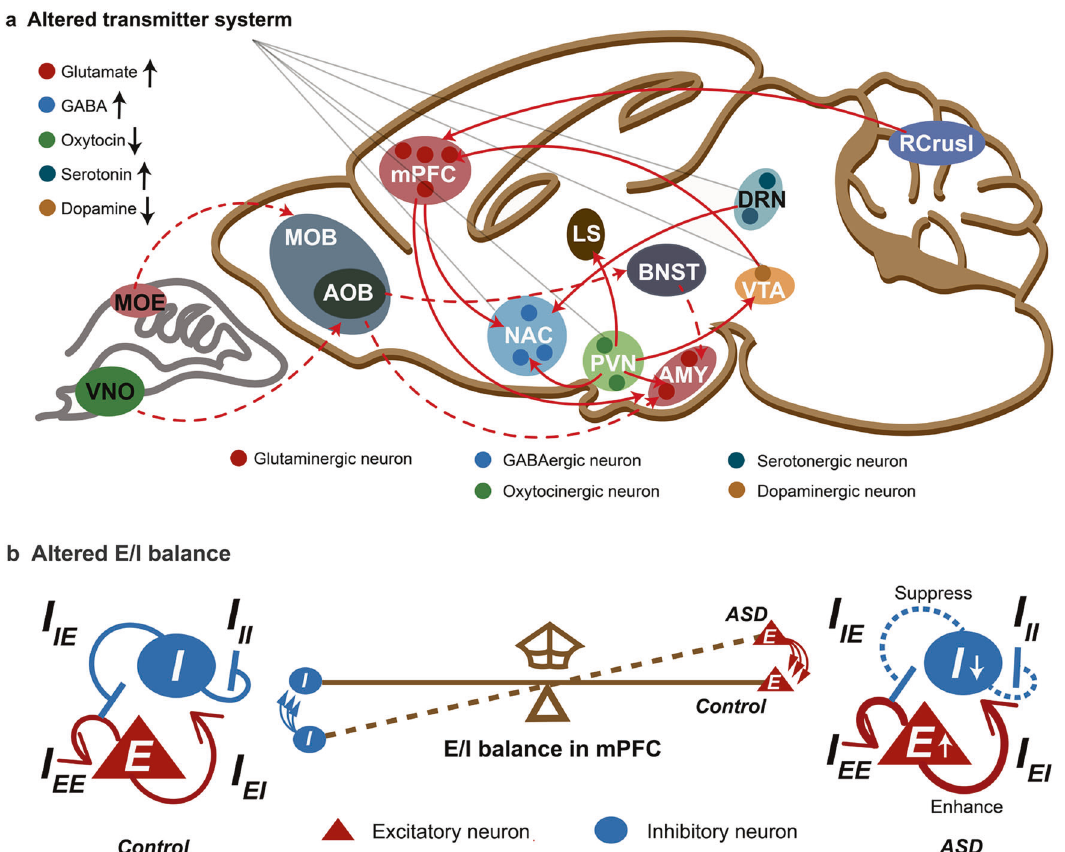
neuroscience, optogenetics, chemical genetics and electrophysiology have illuminated the relationships between various social behaviour and the activity of speci fi c neural circuits. Alterations in brain connectivity usually accompany changes of neurotransmitter, including glutamate, GABA, oxytocin, serotonin and dopamine. b In addition, the hypothesis of disruption of cortical “ E/I imbalance ” in autism is widely accepted, which has also been highlighted in the fi gure. AMY amygdala, AOB olfactory bulb, BNST bed nucleus of the stria terminalis, DRN dorsal raphe nucleus, LS lateral septum, MOB main olfactory bulb, MOE main olfactory epithelium, NAc nucleus accumbens, PFC prefrontal cortex, PVN paraventricular nucleus, RCrusl right Crus I, VNO vomeronasal organ, VTA ventral tegmental